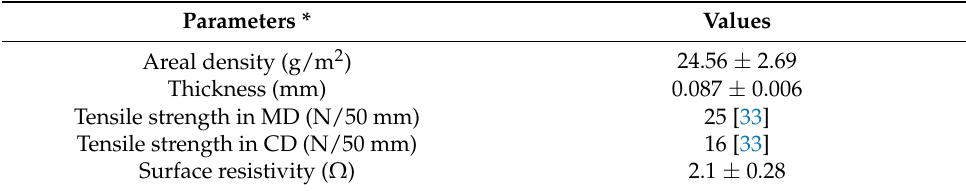
Table 1. Cu/Ni NW fabric parameters and their values.